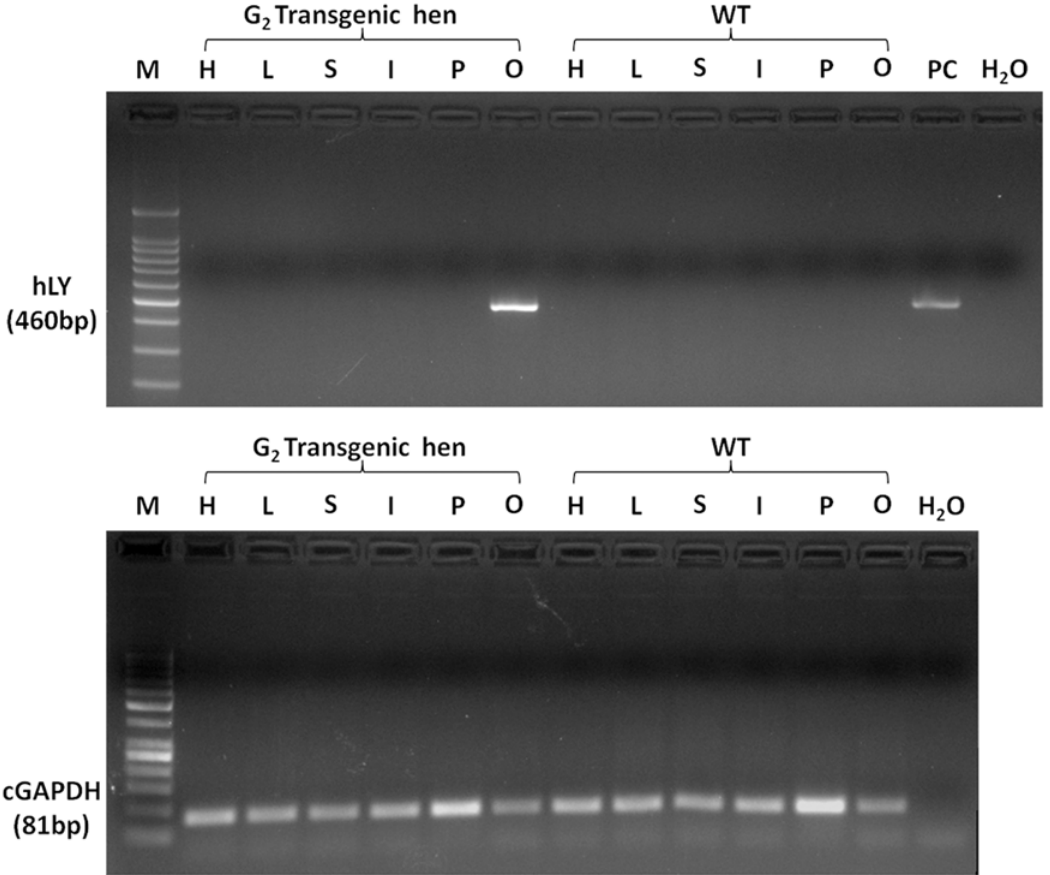
Fig 6. RT-PCR analysis of total RNA from G 2 hens. Total RNA was extracted from the heart (H), liver (L), spleen (S), intestine (I), pectoralis (P) and oviduct (O) of the adult G 2 transgenic hen and non-transgenic hen. RNA expression of hLY were detected from each sample. Chicken GAPDH was used as an internal control for RT-PCR. PC, positive